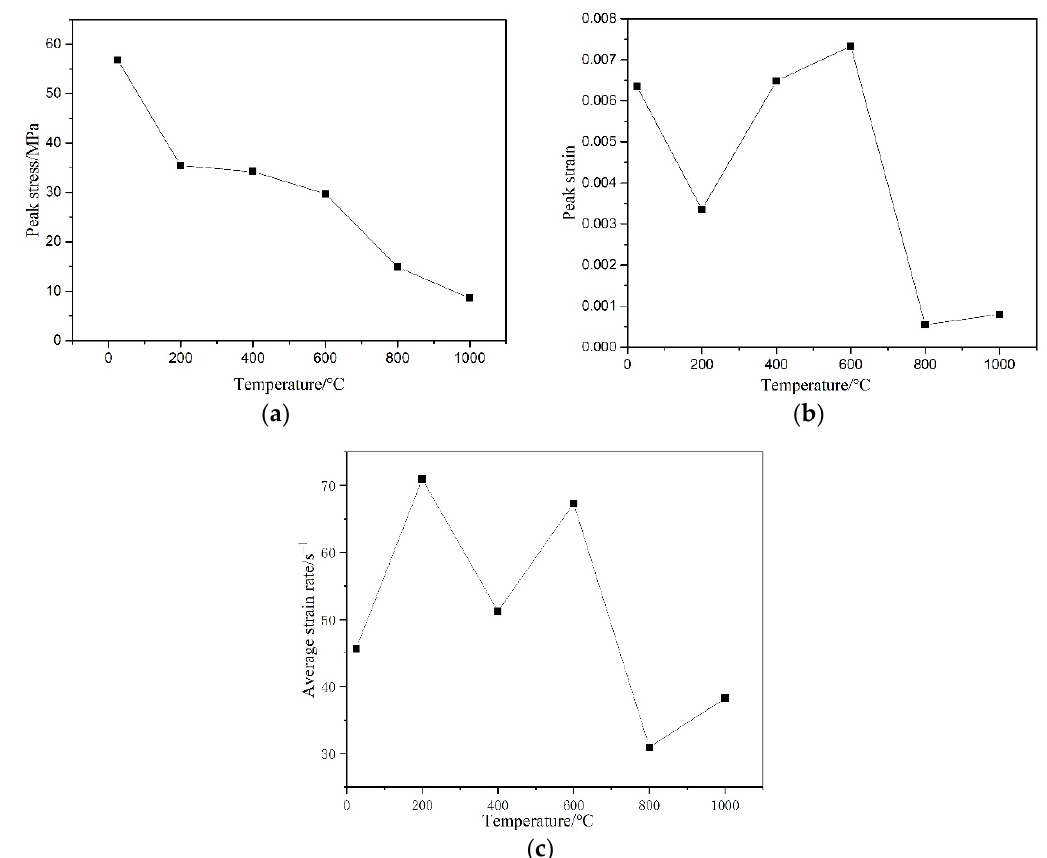
Figure 9. Relationship between first impact dynamic peak stress, peak strain, average strain rate, and temperature of sandstone. ( a ) Relationship between peak stress and temperature. ( b ) Relationship between peak strain and temperature. ( c ) Relationship between average strain rate and temperature.